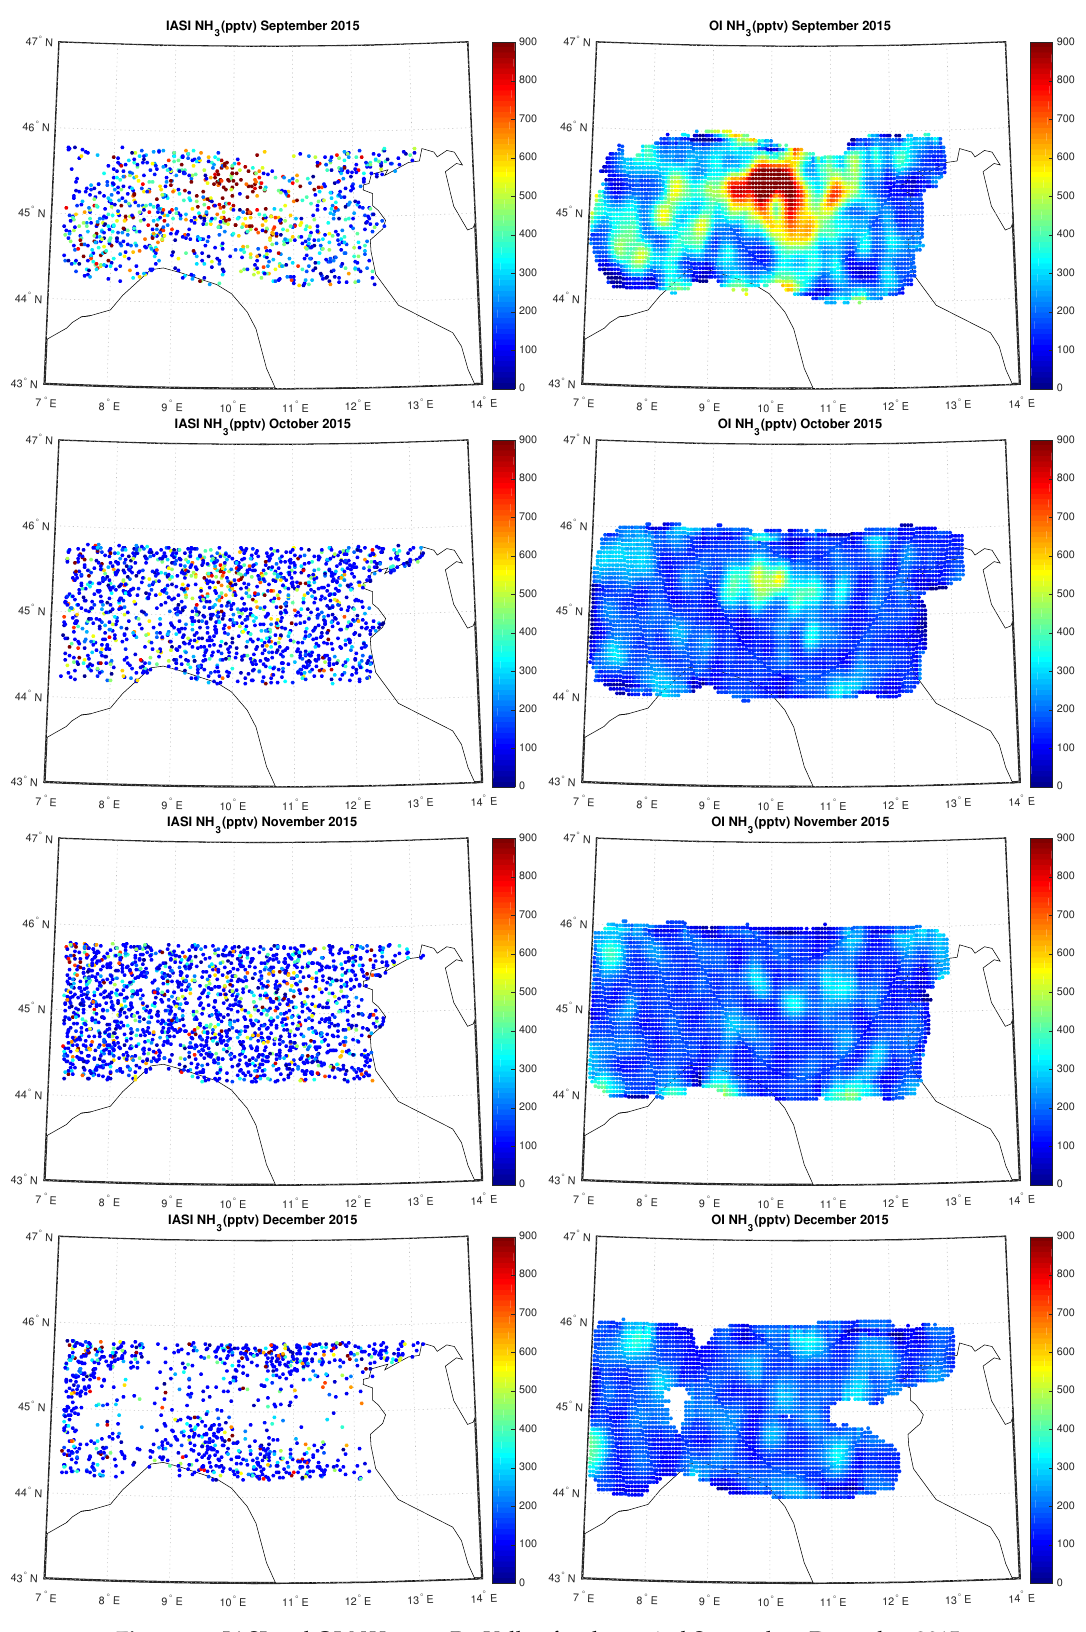
Figure 13. IASI and OI NH 3 over Po-Valley for the period September–December